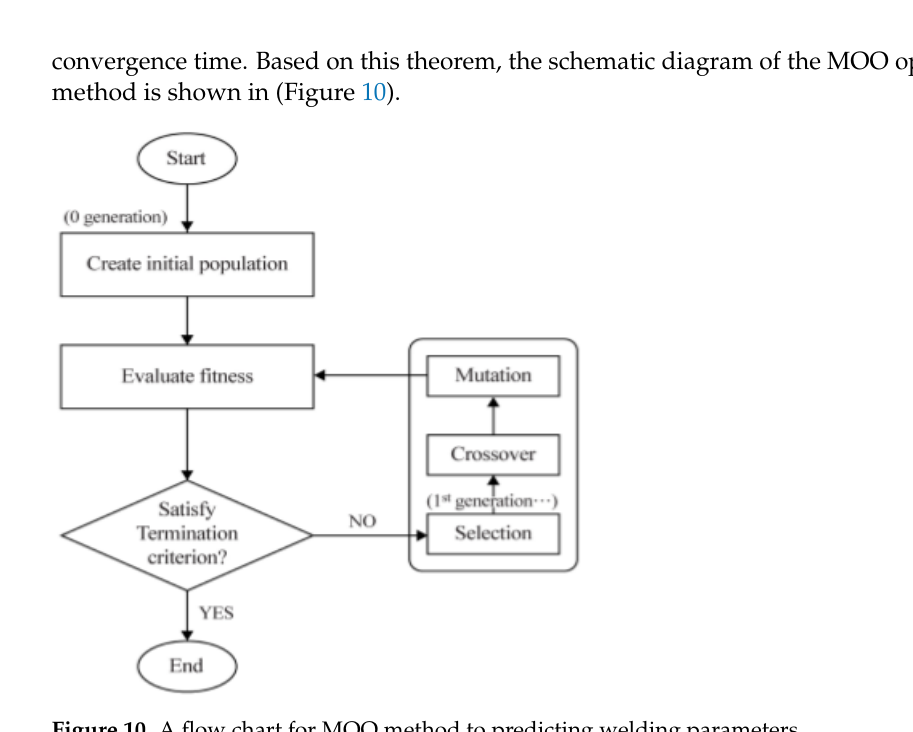
The multipurpose optimization problem can be defined as in Equation (8)